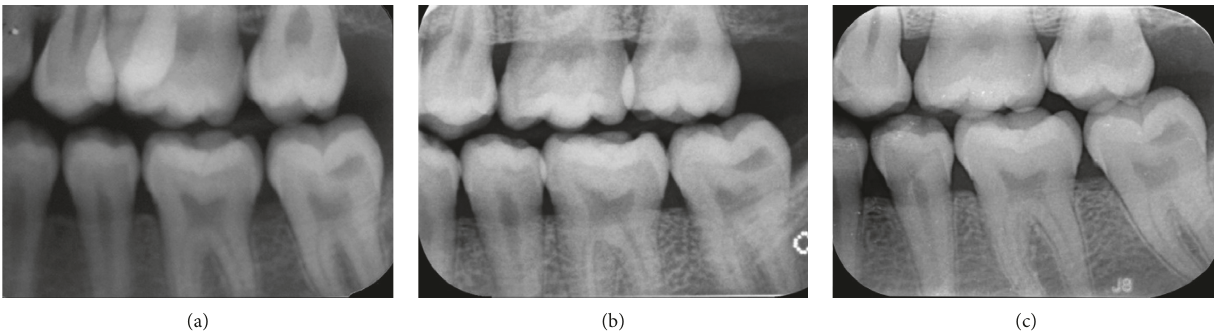
Figure 5: Bitewing radiographs of the PEIR-affected tooth (permanent mandibular left second molar) when the patient was (a) 13 years, 4 months old, (b) 15 years, 3 months old, and (c) 17 years, 4 months old. The PEIR has no connection to the enamel or the pulp of the affected